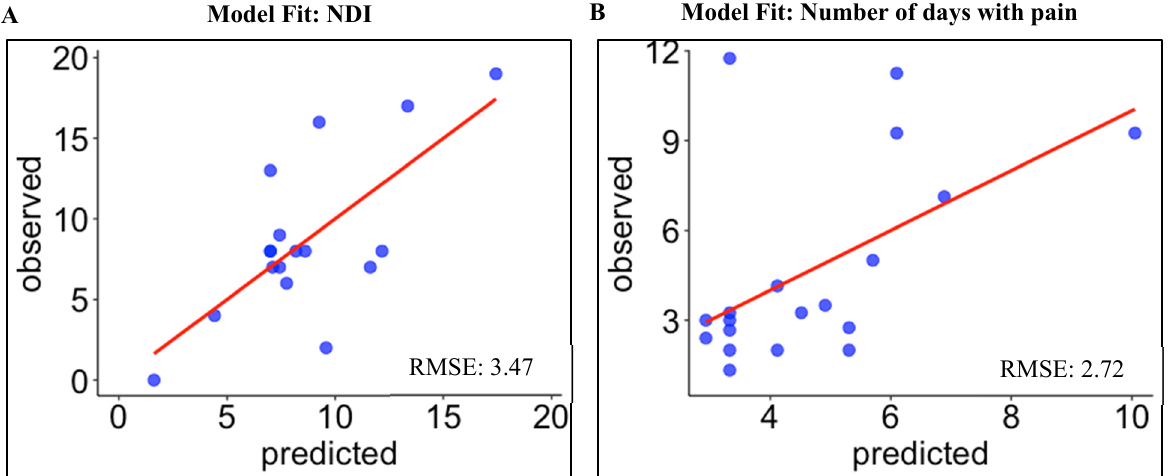
Figure 2. Scatterplots of two models fit comparing the predicted and observed values for each outcome: NDI: Neck Disability Index at six months ( A ) and number of days with pain over the 12-month follow-up period ( B ). The diagonal line in red indicates perfect prediction. RMSE: root mean square error, which represents the error between predicted and observed values in each generated prognostic model. Lower values of RMSE indicate better prediction.